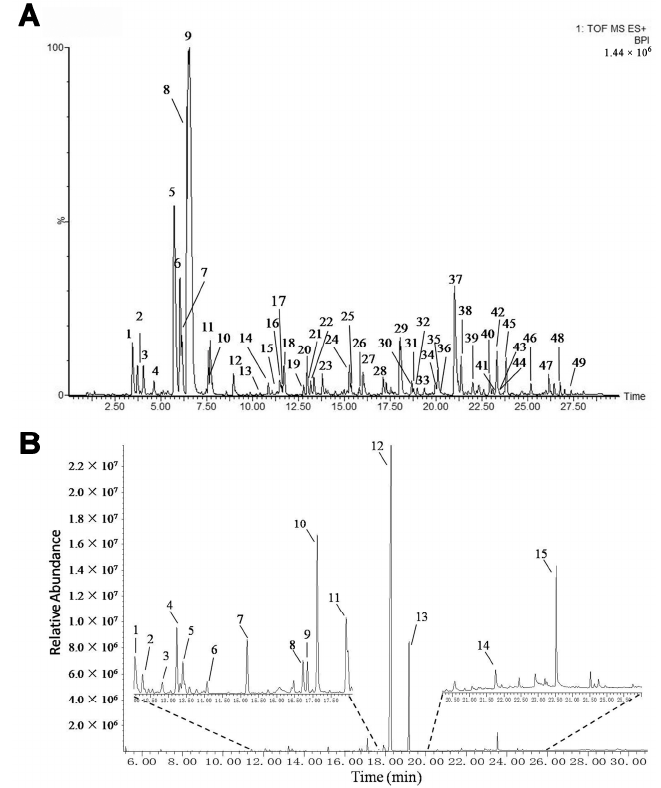
Figure 1. BPI chromatogram of mKG extract ( A ) in positive ion mode analyzed by UPLC-Q-TOF/MS, and TIC chromatogram of Angelica oil ( B ) analyzed by using GC-MS.